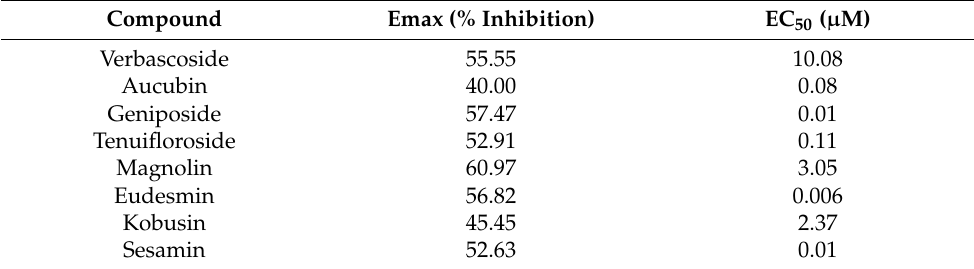
Table 1. Parameters calculated from the concentration response curve, measured as inhibition of NF- kB/AP-1 activity, in the RAW-blue™ cell culture. E max and EC 50 of verbascoside, iridoids glycosides, and lignans isolated from C. tenuiflora methanolic